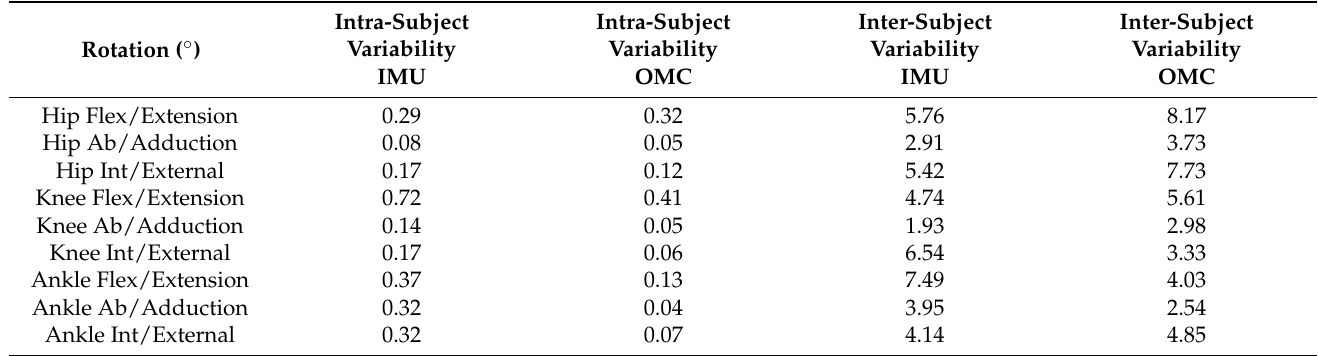
Table 1. Average intra-Subject variability and inter-subject variability over the amputee gait cycle among the thirty participants for both systems.